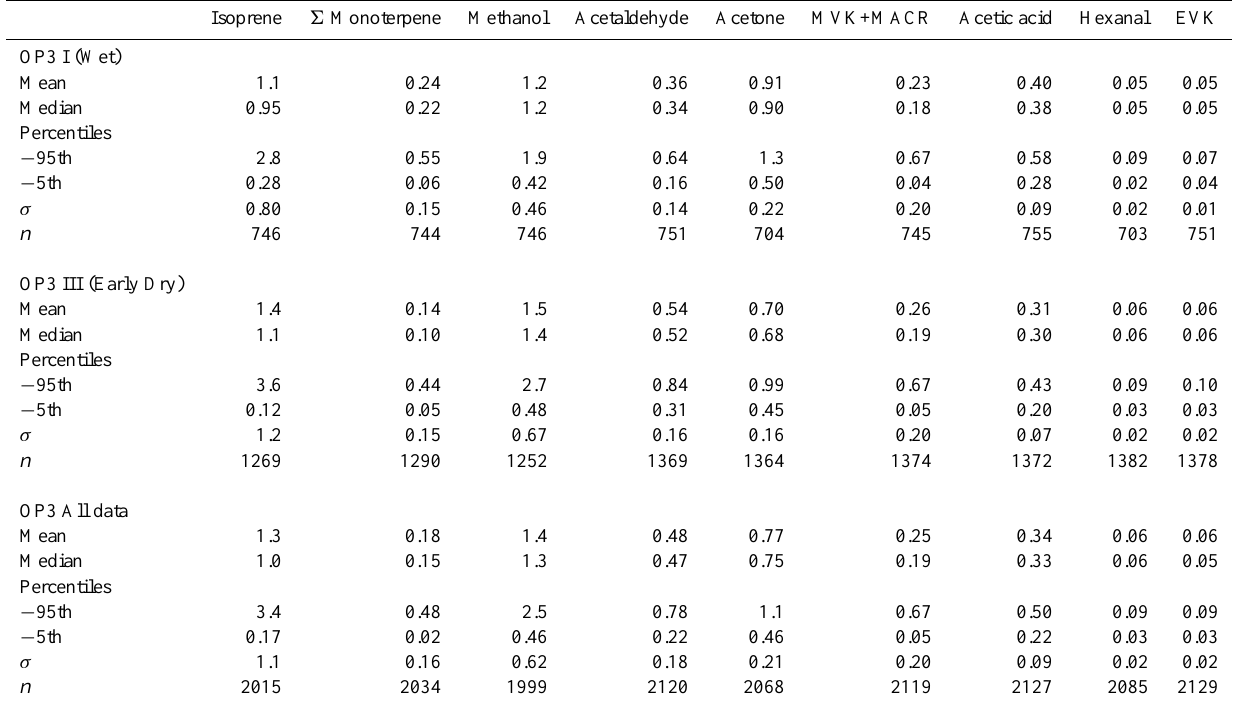
Table 2a. Summary of VOC mixing ratios (ppbv) measured during the two intensive OP3 campaigns. Isoprene